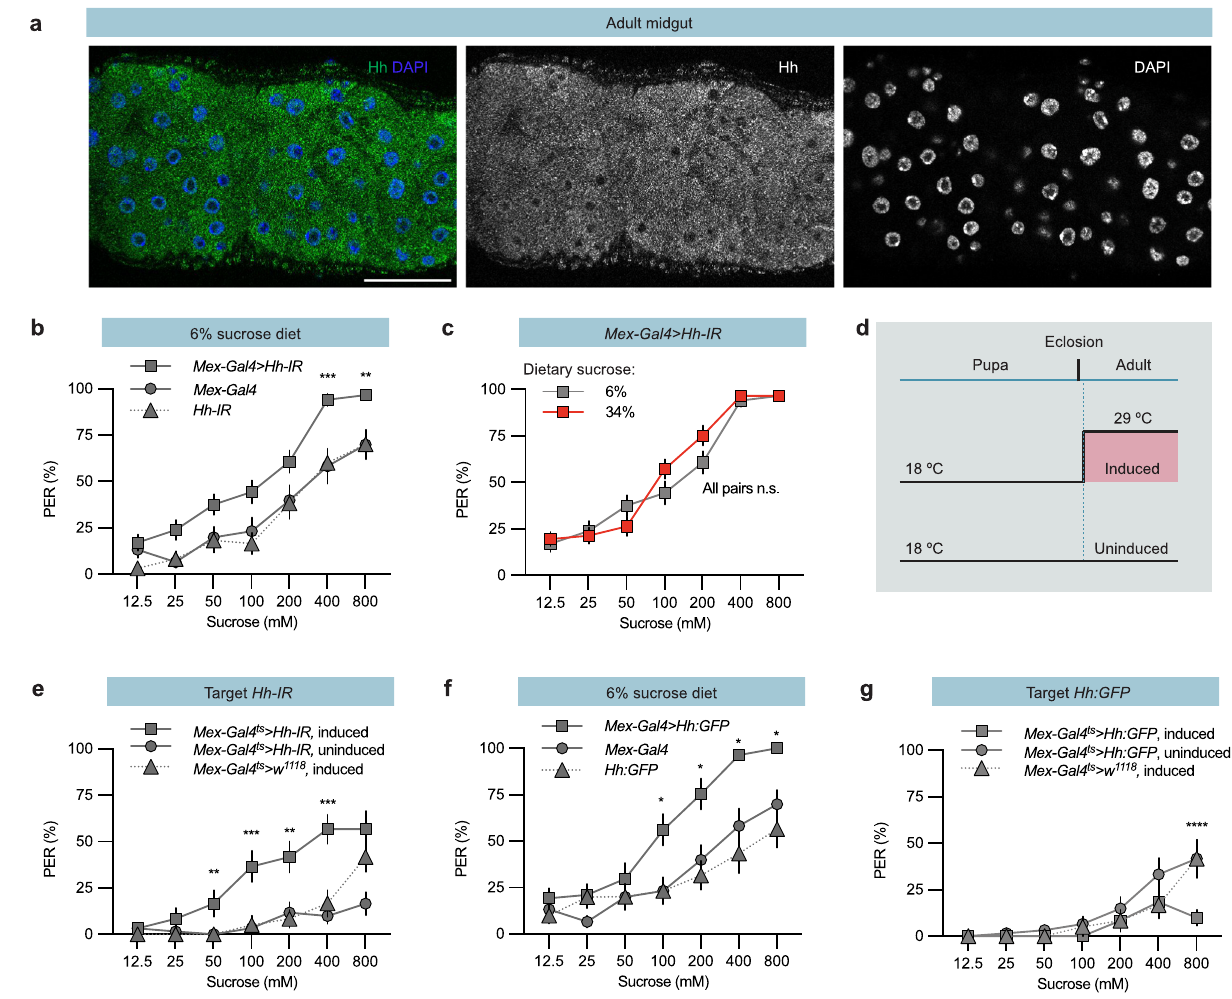
Fig. 2 | Gut Hhregulatessweet tasteresponses.a Representative confocalimage ofamaleadult w 1118 midgut.Anti-Hhstainingisshowningreen,DAPIstainsnucleiin dark blue in the merged image. Scale bar, 50 µ m. b Knocking down Hh in gut enterocytes ( Mex > Hh-IR) produced a signi fi cant increase in sucrose-induced PER. c Mex > Hh-IR fl iesshowedasimilarPER%whenrearedontheindicatedsugardiets. d TARGET experiment schematic. Flies were maintained at 18°C to restrict Gal4 activity. Newly eclosed fl ies were shifted to 29°C for 4 days to induce gene expressionormaintainedintheuninducedstateat18°C. e Plotshowingafour-day TARGET induction of Hh-IR expression in the enterocytes of adult males leads to a